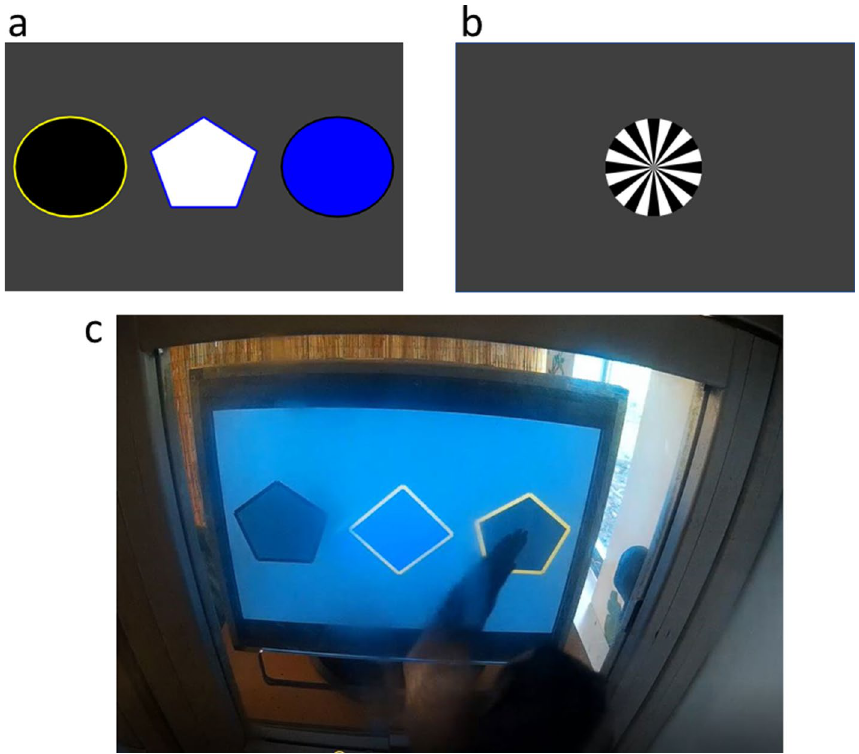
Figure 1. Example 3-stimulus problems. ( a ) At the beginning of an information trial (T1) or test trial (T2), stimuli are displayed on the screen. (If this represents a T1, the following test trial would look identical to this screen.) ( b ) If a rewarded stimulus is selected, a visual cue (sunburst) is displayed and an auditory click is produced as feedback. If a monkey selected the rewarded stimulus, a food reward is also dispensed; if a child selected the rewarded stimulus, they are allowed to add a sticker to their sticker sheet. If an unrewarded stimulus is selected (not pictured), the stimuli disappear and only the background is visible. ( c ) An individual monkey interacting with the apparatus. This is a different problem from that displayed in ( a , b